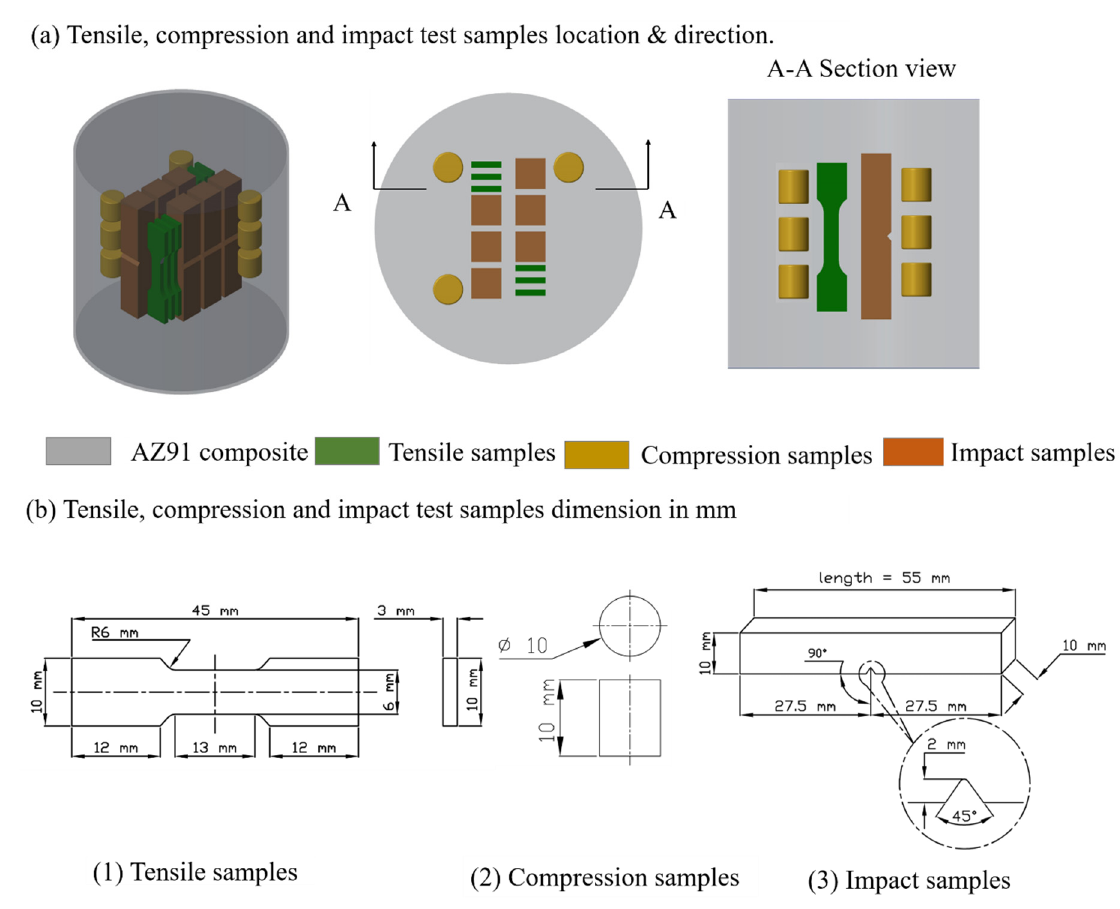
Figure 2. Schematic illumination of the dimensions of the tensile, compression and impact samples and the direction of the alloy composites.